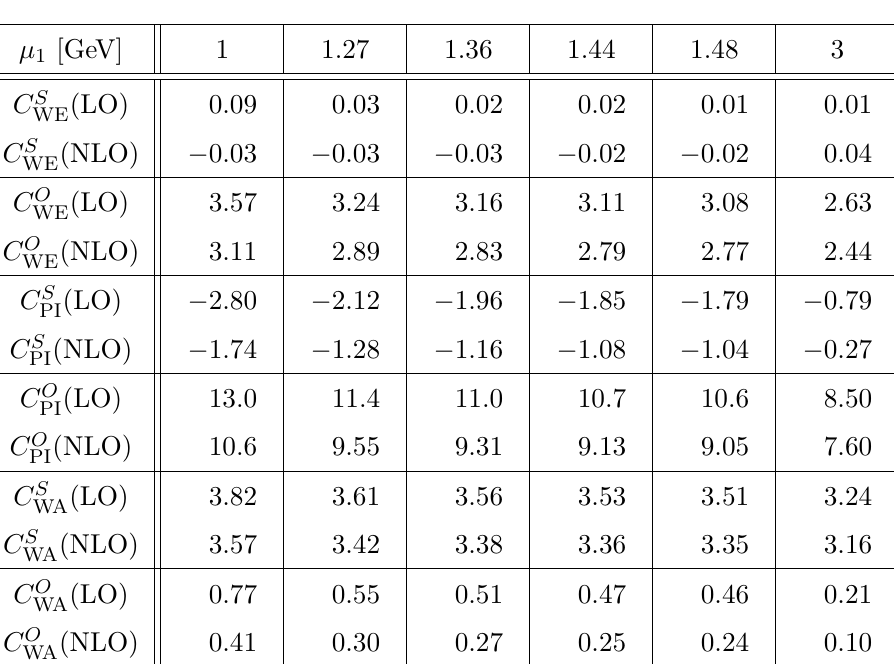
Table 8 . Comparison of the combinations C S,O different values of the renormalisation scale µ